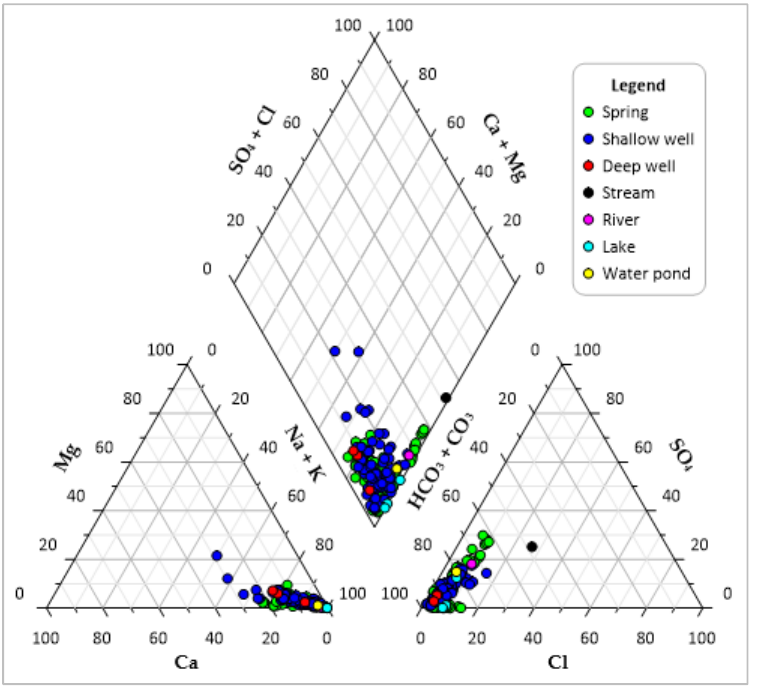
Figure 5. Piper diagram showing different water samples taken from springs, shallow wells, deep wells, stream, river, lakes, and water ponds.